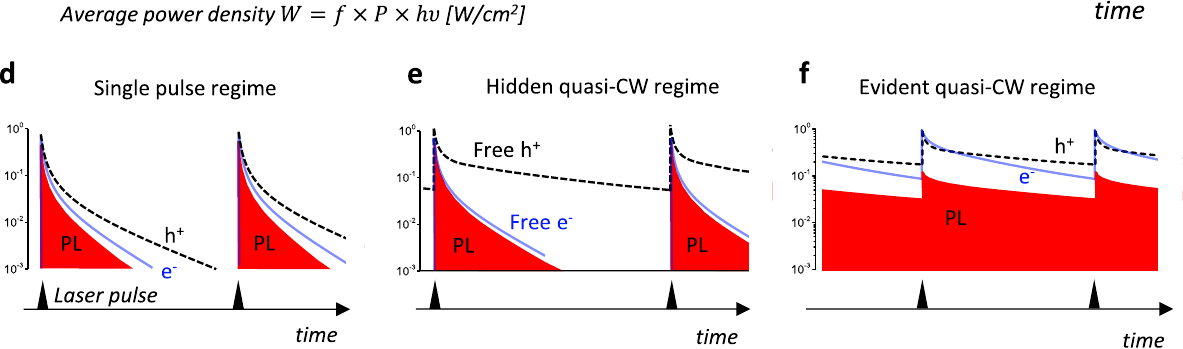
Fig. 1 PLQY( f , P ) map and illustration of the difference between scanning the pulse repetition rate ( f ) and scanning of the pulse fl uence ( P ). a PLQY (W) dependence plotted in the traditional way ( P -scanning) for 19 different pulse repetition rates. The datapoints measured at the same frequency are connected by lines, the sample is MAPbI 3 fi lm grown on glass (G/MAPI). The apparent slope of these dependencies ( m , PLQY ~ W m ) depends on the range of W and the value of f and can be anything from 1 to 0.77 for this particular sample. b The same data plotted in the form of a PLQY( f , P ) map where data points measured at the same pulse energy ( P 1, P 2, ..., P 5) are connected by lines ( f -scanning). Data points measured at 50 kHz frequencies are connected by a dashed-dotted line. c The excitation scheme. Illustrations of PL decays in the single pulse ( d ) and quasi-CW ( e , f ) excitation regimes. Here e − trapping is assumed leading to h +